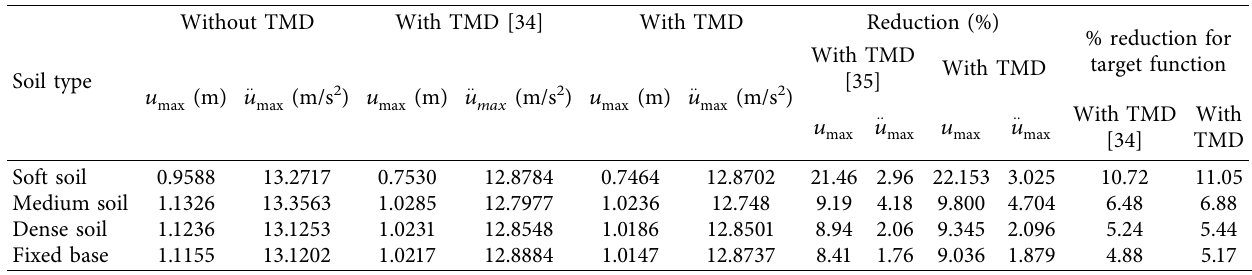
Table 4: Vibration with and without